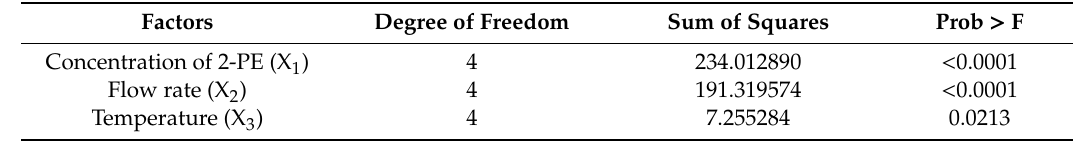
Figure 3. A linear relationship between the predicted and experimental molar conversion of 2-PEAC. Table 3. Analysis of continuous synthesis variance of 2-PEAc in joint test ANOVA for substrate concentration pertaining to the response (initial